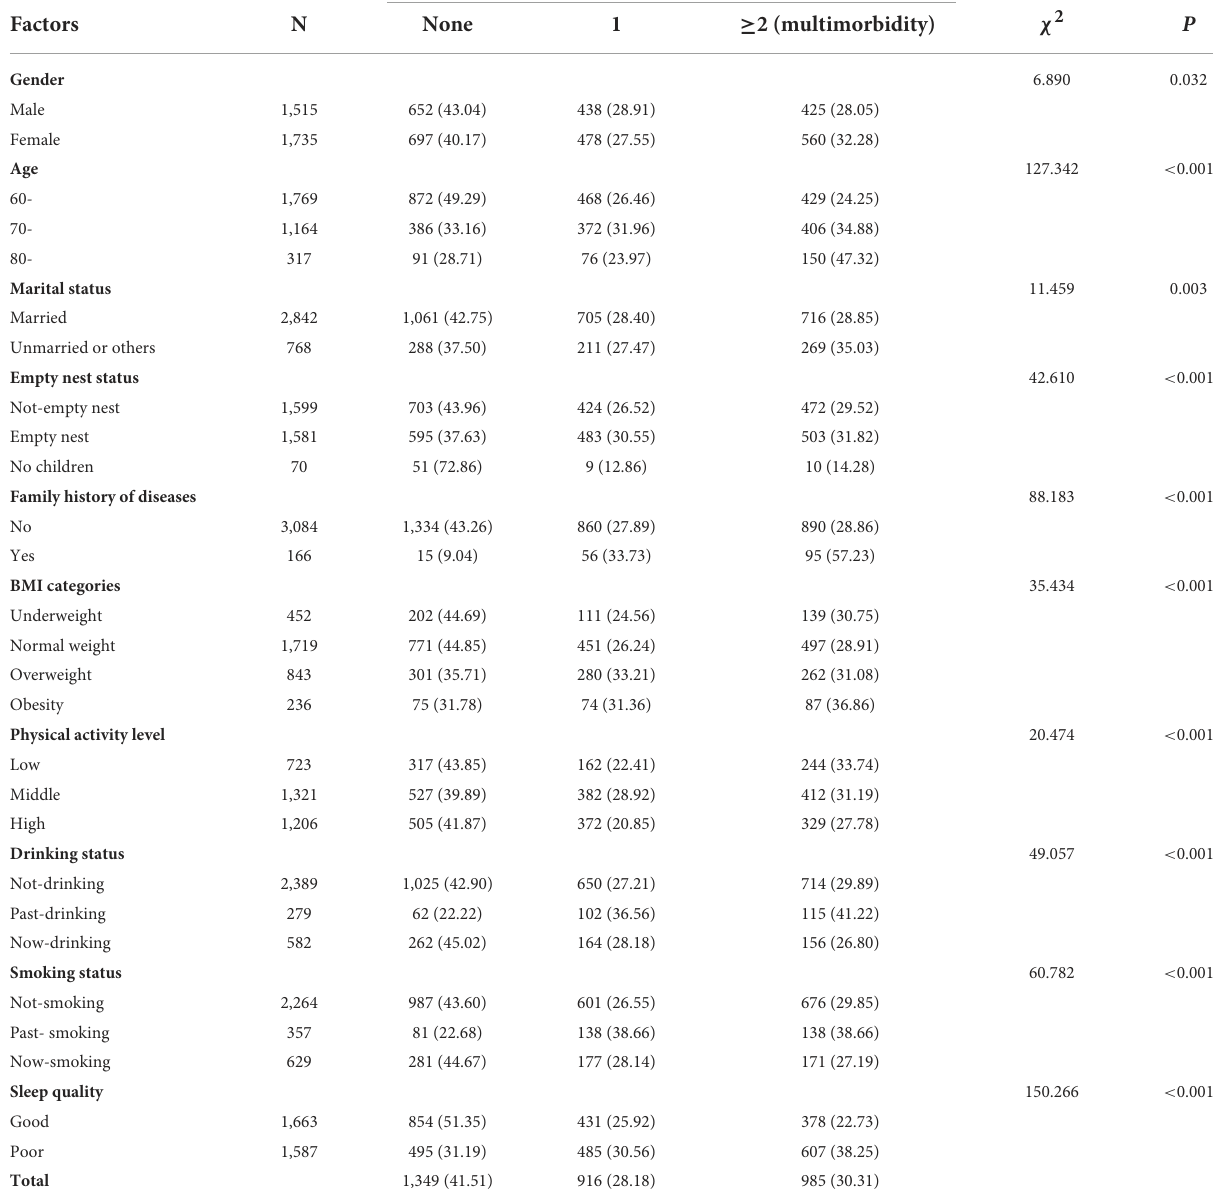
TABLE 1 Multimorbidity with sociodemographic, lifestyles, and sleep quality in older adults. Types of chronic diseases [ N